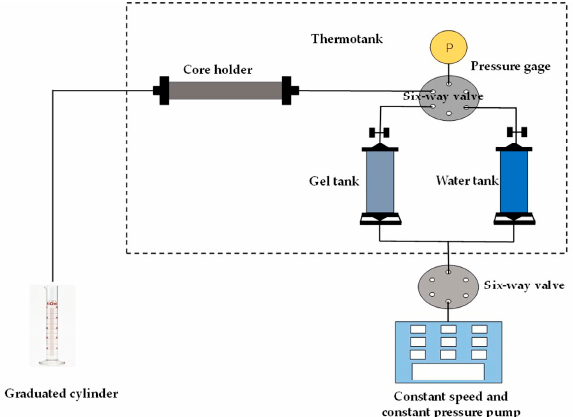
Figure 2. Schematic diagram of the gel performance characterization experimental device.